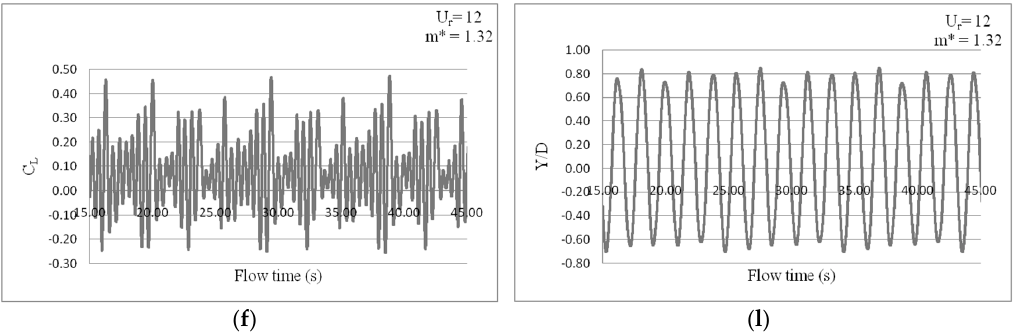
Figure 5. Time histories of hydrodynamic and structural response parameters at m* = 1.32: ( a ) C L for U r = 4; ( b ) C L for U r = 5; ( c ) C L for U r = 6; ( d ) C L for U r = 8; ( e ) C L for U r = 10; ( f ) C L for U r = 12; ( g ) Y/D